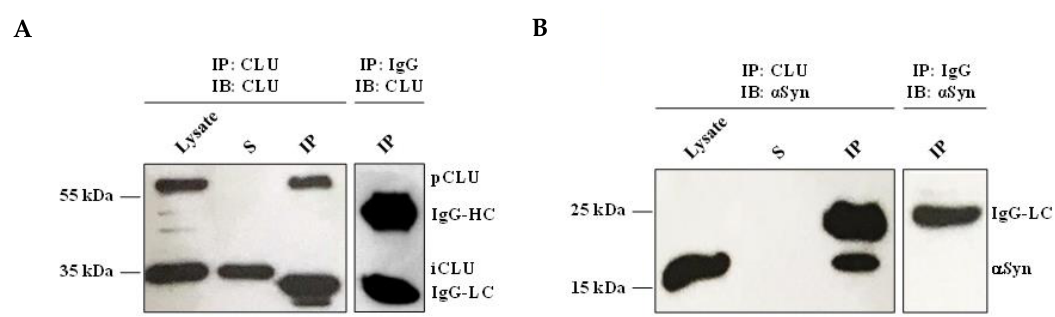
Figure 7. Interaction of CLU and α Syn in SH-Syn. ( A ) Detection of CLU in the SH-Syn intracellular protein fraction (Lysate) immunoprecipitated with the anti-CLU antibody. ( B ) Detection of α Syn in the SH-Syn intracellular protein fraction (Lysate) immunoprecipitated with the anti-CLU antibody. Immunoprecipitation with IgG was performed as a negative control. IP: Immunoprecipitated fraction; S: Fraction containing the proteins that do not interact with CLU; Lysate: 1% Triton X-100 protein soluble fraction of SH-Syn; IgG-HC: IgG Heavy chain; IgG-LC: IgG Light chain.